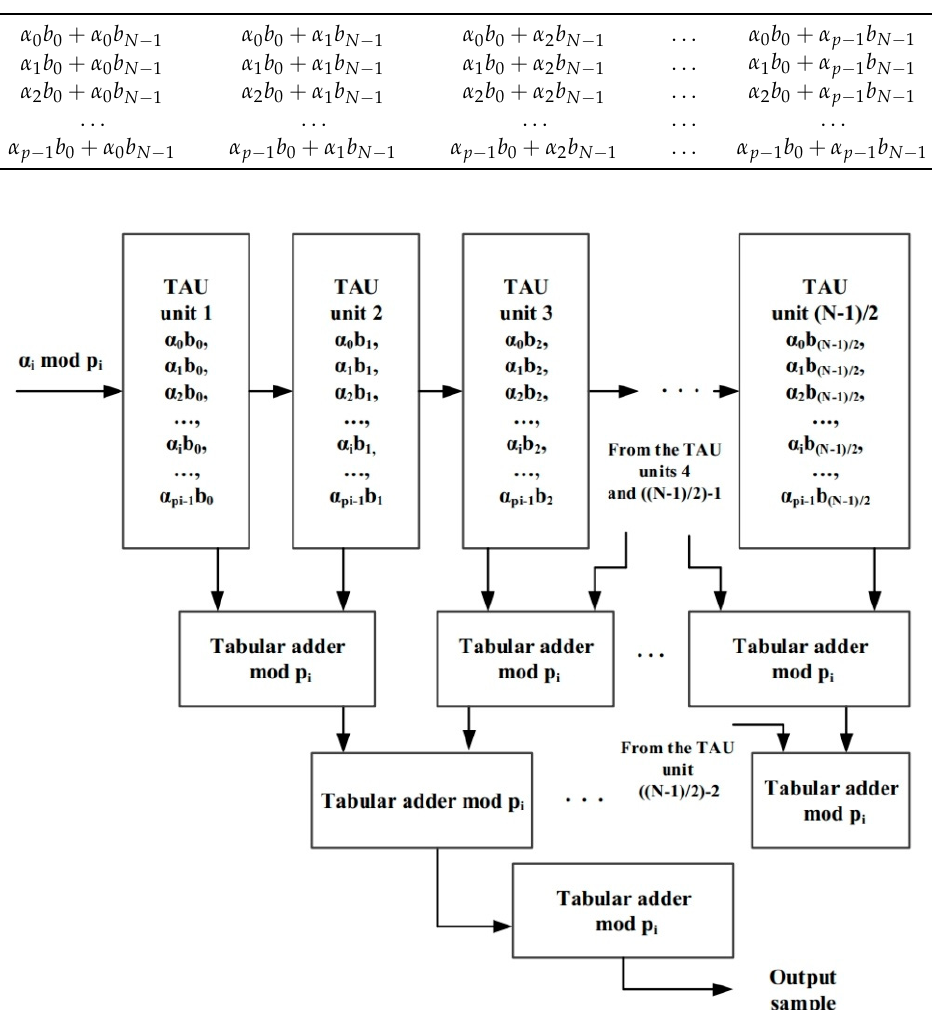
Figure 3. Modified structure of the DF on the basis of the algebra of the finite residue field. DE here is a delay element, TM is a tabular multiplier, and TA is a tabular adder.